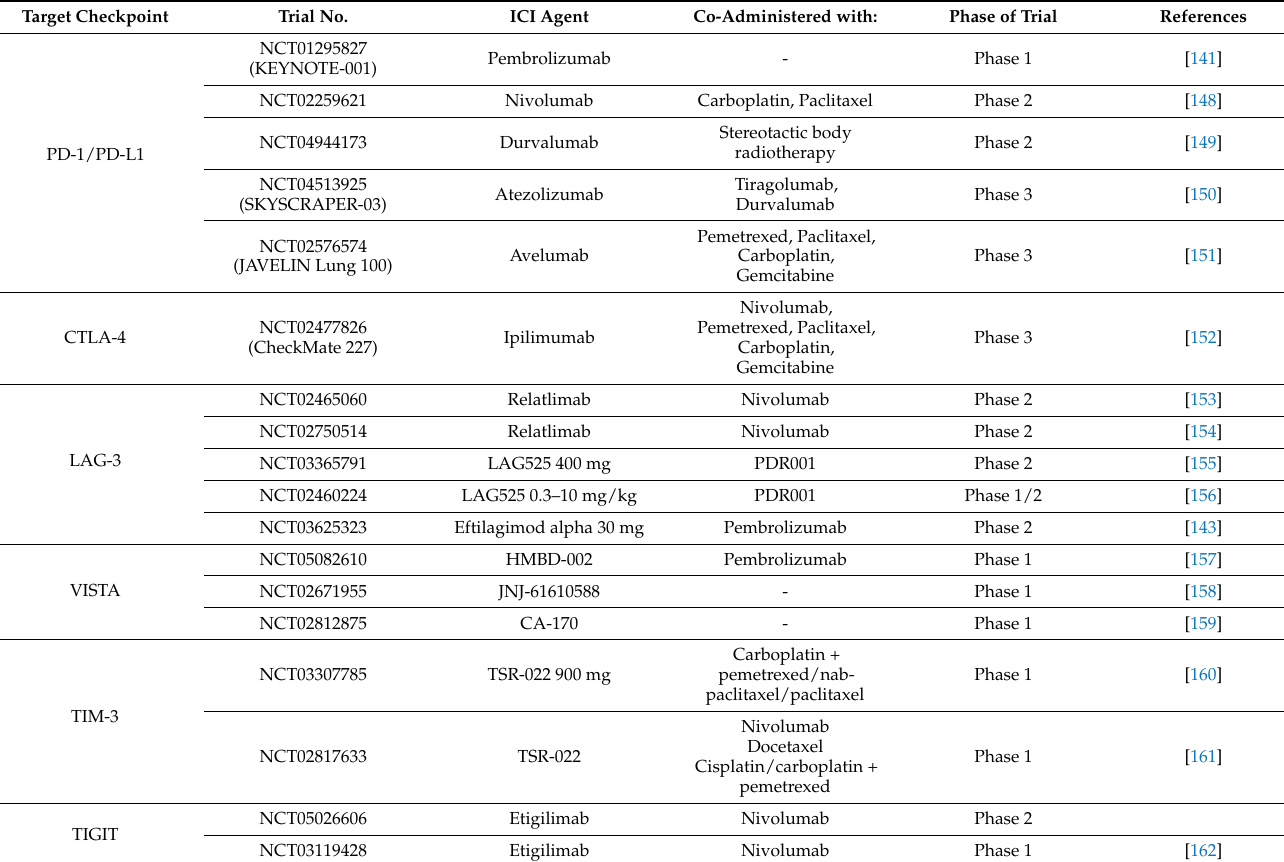
Table 2. Clinical trials of ICIs targeting prototypic and alternative immune